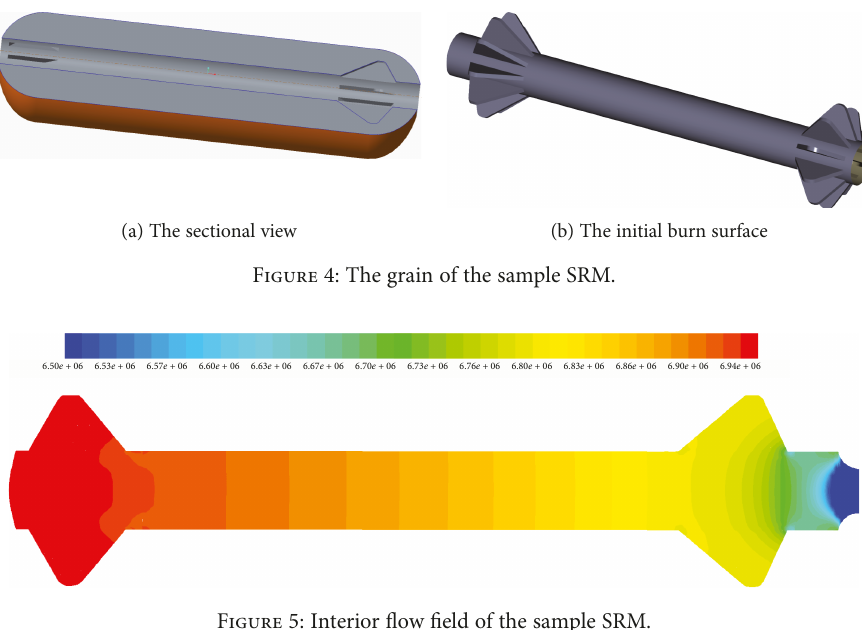
Figure 5: Interior fl ow fi eld of the sample